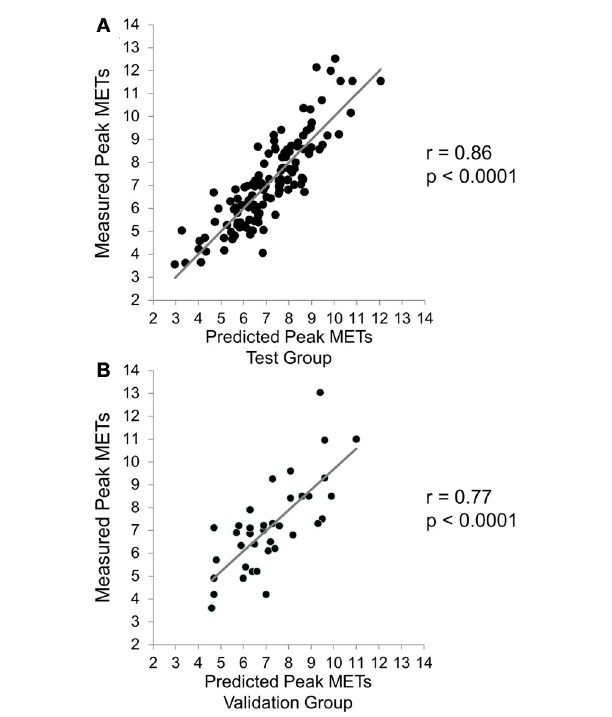
FIGURE 1 | Regression between predicted peak exercise capacity (MET peak ) and measured from the test (A) and validation (B) groups of coronary artery disease